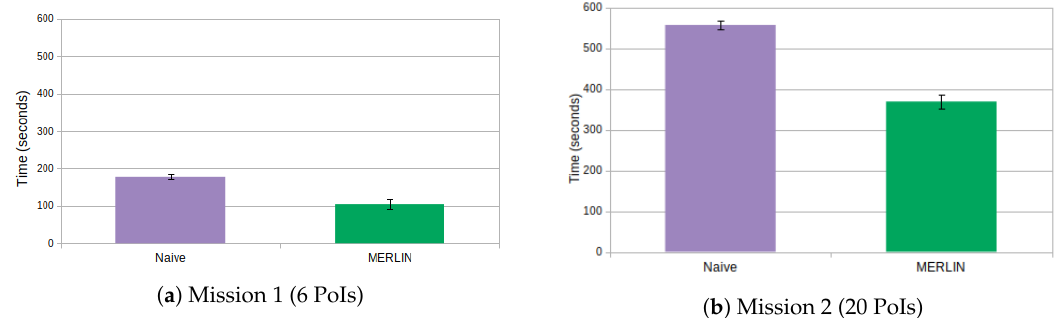
Figure 10. Time needed for fulfilling the missions using Naive and MERLIN